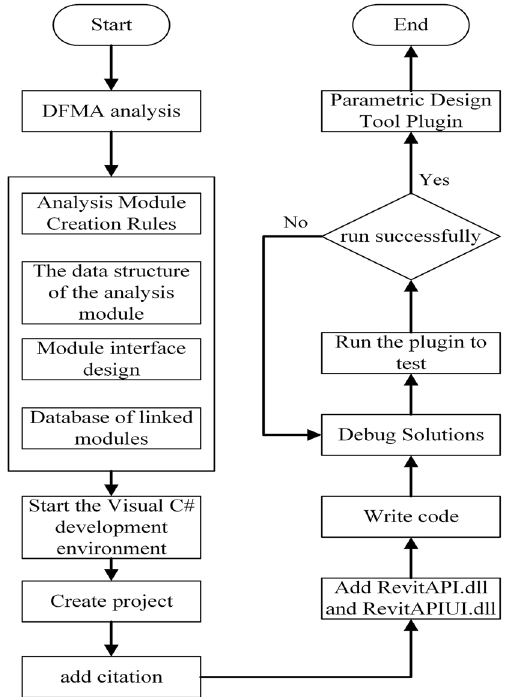
Figure 8. Module development process for DFMA and